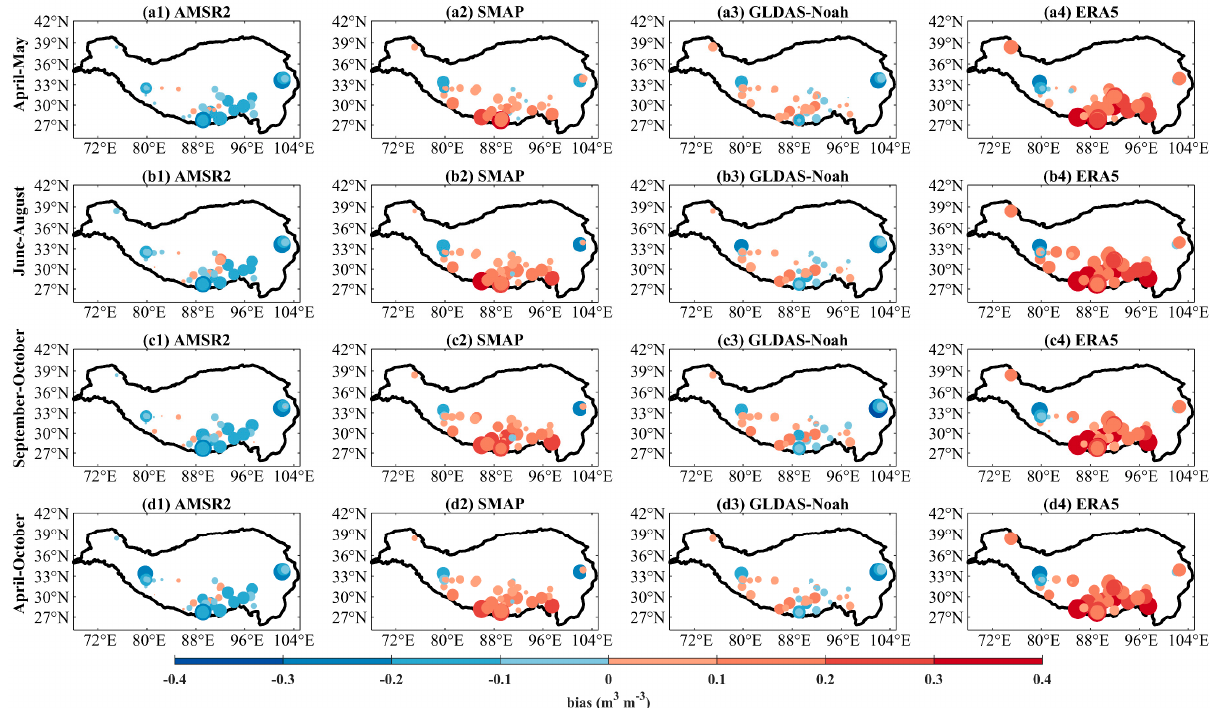
Figure 9. Spatial distributions of bias for daily AMSR2, SMAP, GLDAS-Noah, and ERA5 SM in different seasons from 2015 to 2016 in the TP. The size of the circles represents the absolute value of bias at each observation site.